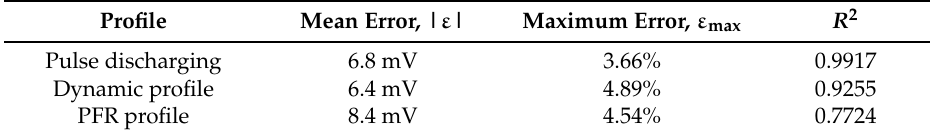
Table 2. Performance model accuracy for different load profiles. PFR: primary frequency